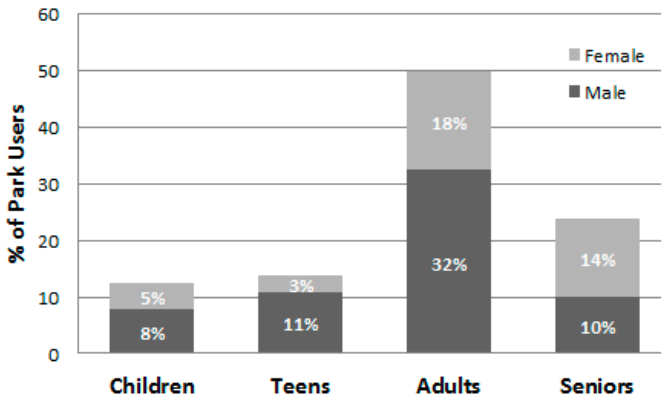
Figure 1. Percent of observed park users by age and gender ( n = 28,585).